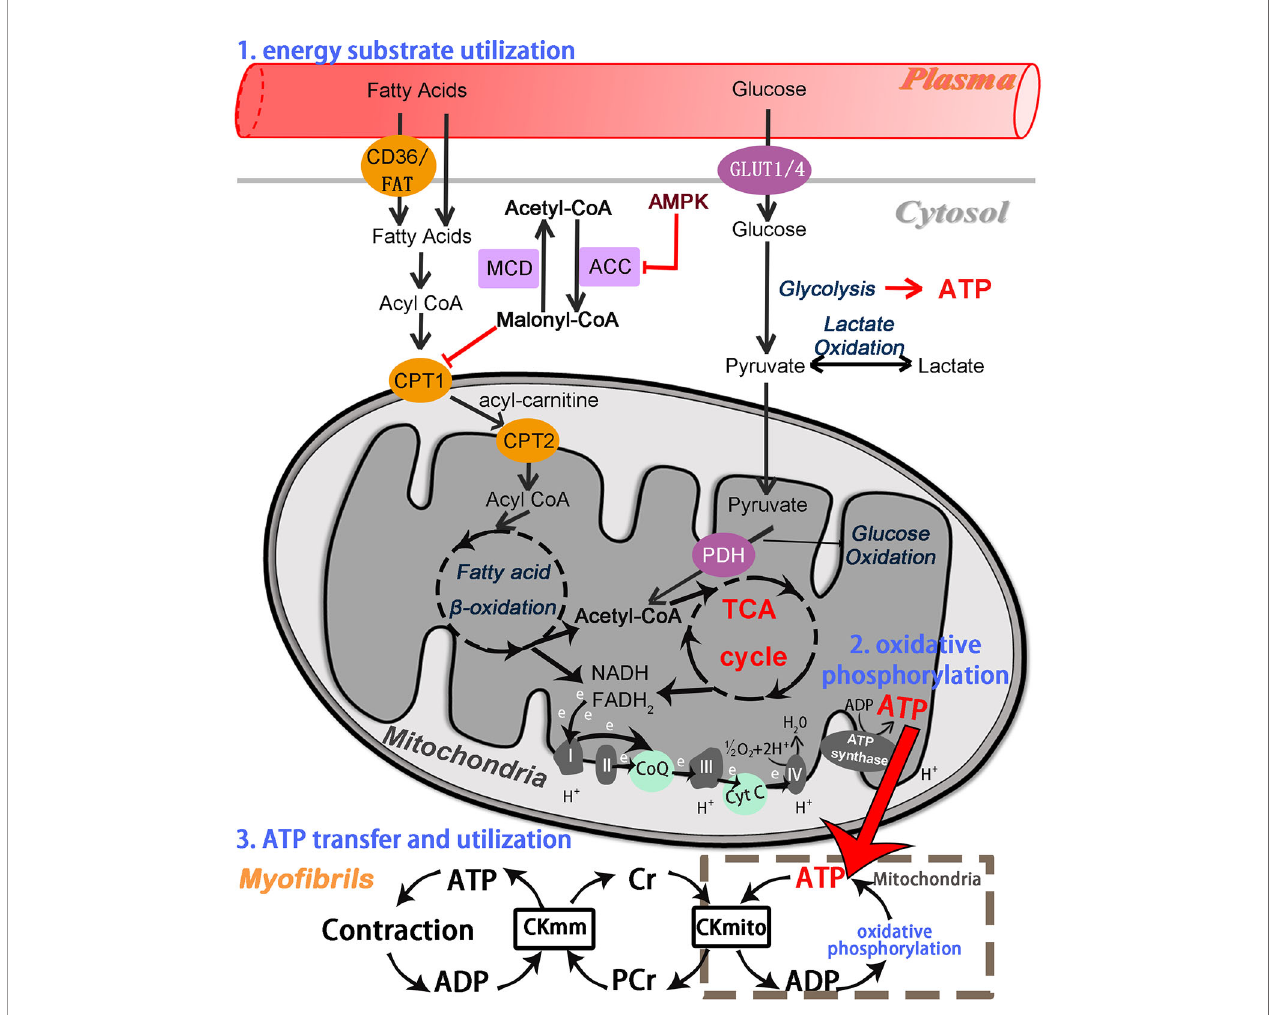
FIGURE 1 | Overview of the cardiac energy metabolism. Fatty acid beta-oxidation and glucose oxidation in mitochondria, respectively, yield acetyl-CoA, which is fed into the TCA cycle to produce NADH and PADH 2 . These further enter the mitochondrial electron transport chain and then drive ATP synthesis. GLUT, glucose transporter; CPT1 and CPT2, carnitine palmitoyltransferase 1 and 2; PDH, pyruvate dehydrogenase; TCA, tricarboxylic acid cycle; NADH, nicotinamide adenine dinucleotide; FADH 2 , fl avin adenine dinucleotide; CoQ, coenzyme Q (ubiquinone); Cyt C, cytochrome C; ATP, adenosine triphosphate; ADP, adenosine diphosphate; H + , hydrogen ion; PCr, phosphocreatine; Cr, creatine; CKmito, mitochondrial creatine kinase; CKmm, myo fi brillar creatine